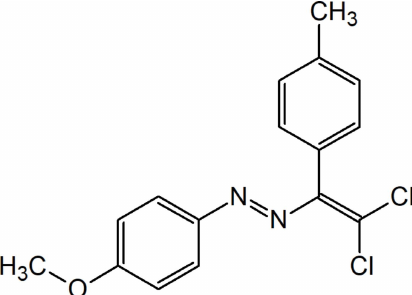
Figure 2 The crystal packing of the title compound viewed along the b